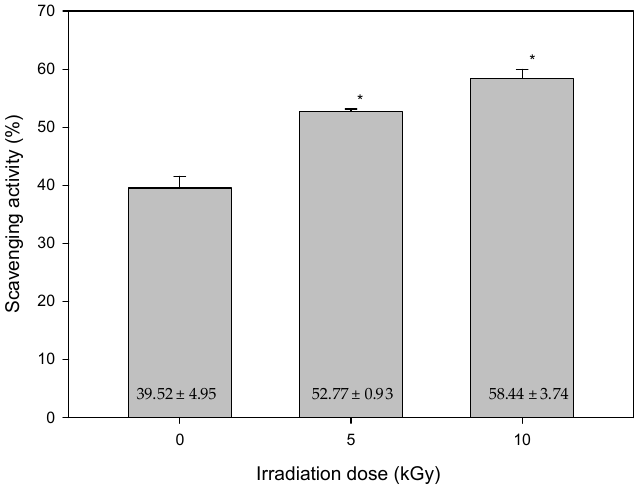
Figure 5. DPPH radical scavenging activities of non-irradiated (0 kGy) and irradiated (5 or 10 kGy) mung beans. (mean ± standard deviation, * p < 0.001; N = 20/group). mung beans. (mean ± standard deviation, * p < 0.001; N =